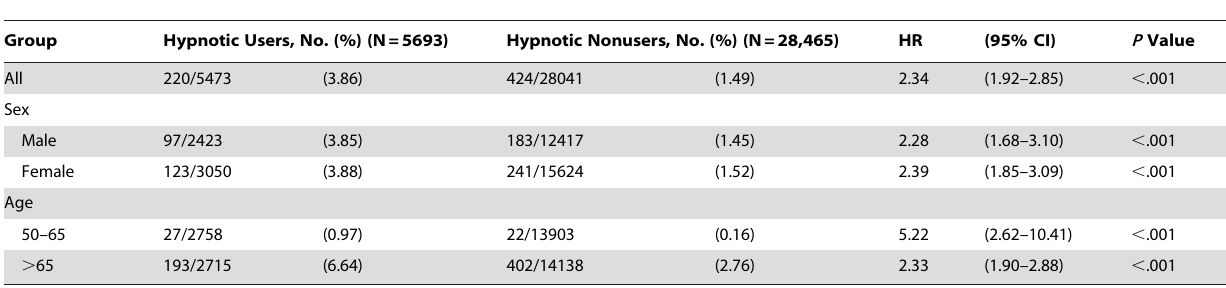
Table 3. Hazard ratios of dementia in patients with and without hypnotic usage stratified by age and sex.